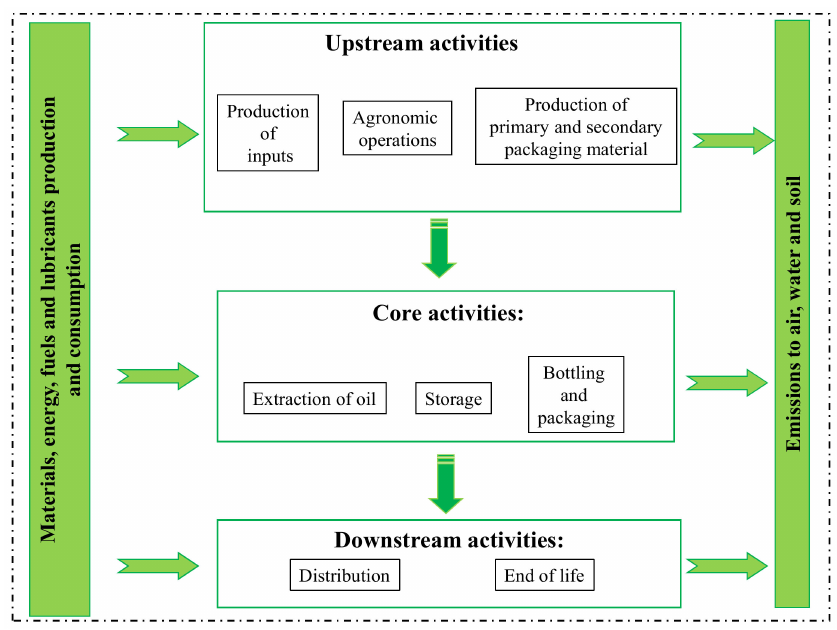
Figure 2. System boundaries for life cycle assessment